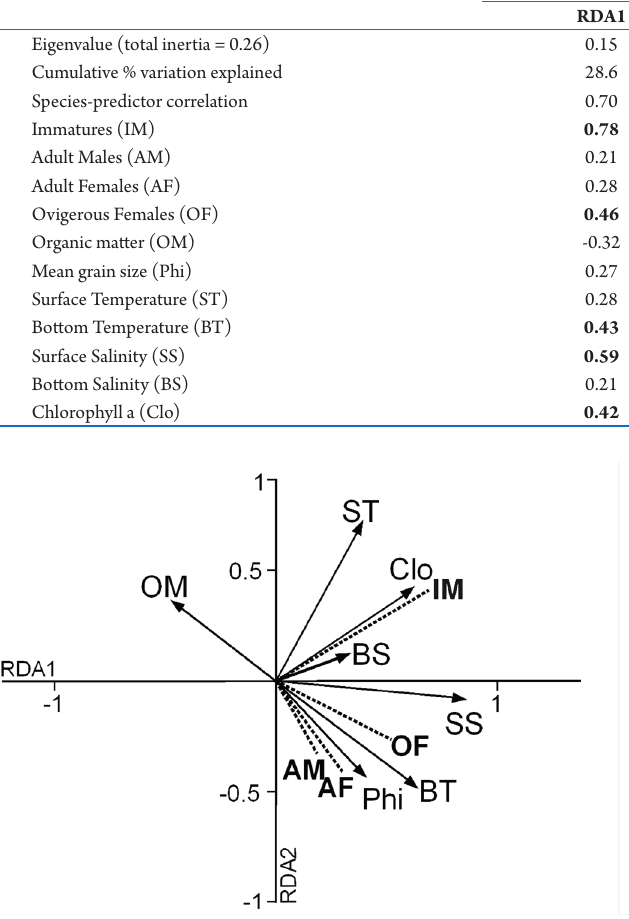
Figure 2 . Biplot of the redundancy analysis (RDA) of variations in environmental variables (indicated by solid arrows) of demographic groups of the swimming crab Achelous spinimanus (indicated by dashed arrows). Refer to Tab. 2 for codes of each demographic group and environmental variable.